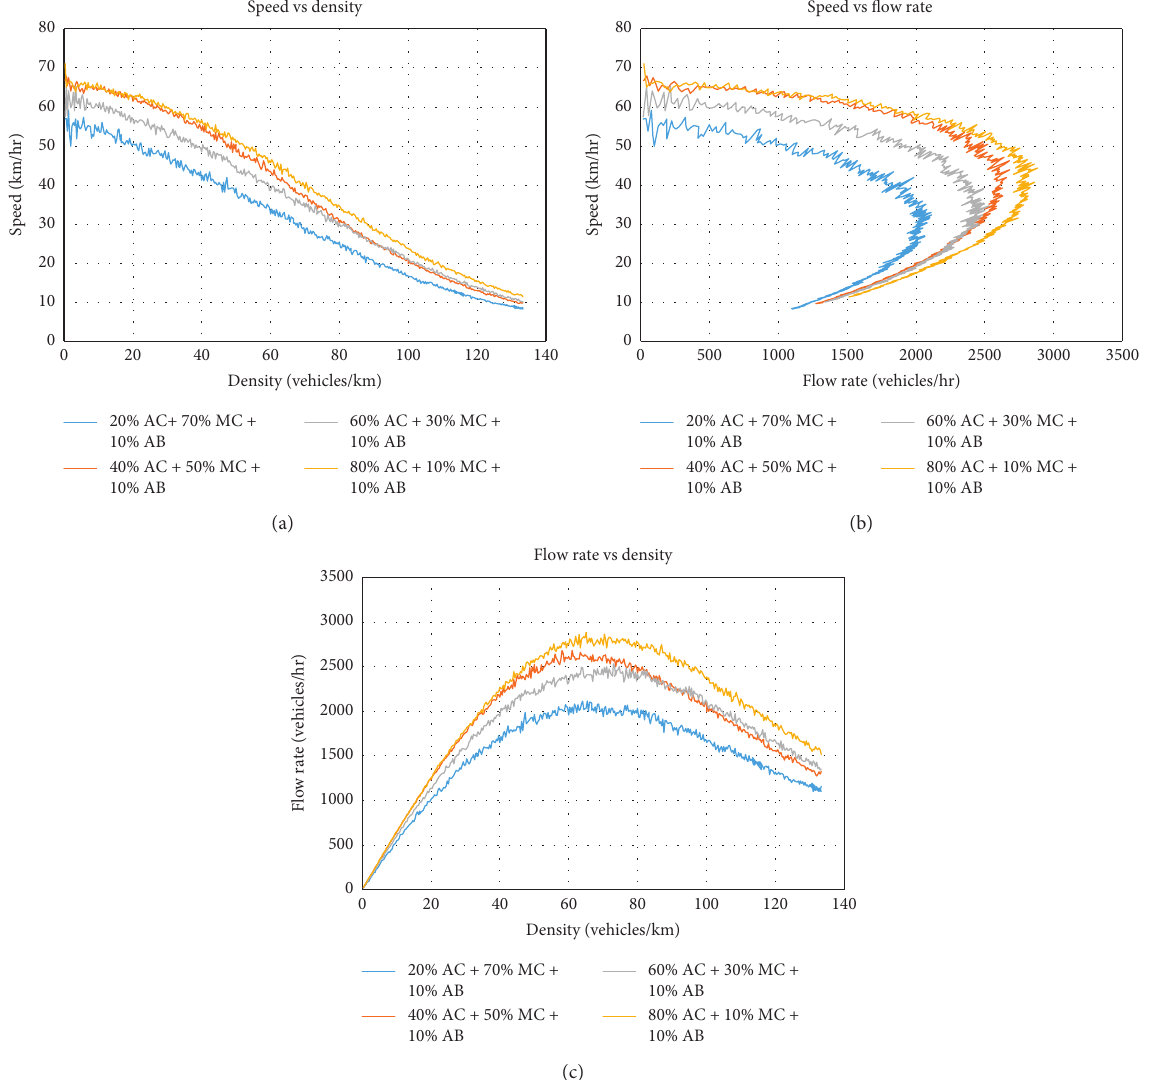
Figure 5: Traffic flow fundamental diagrams for different compositions of AC, MC, and